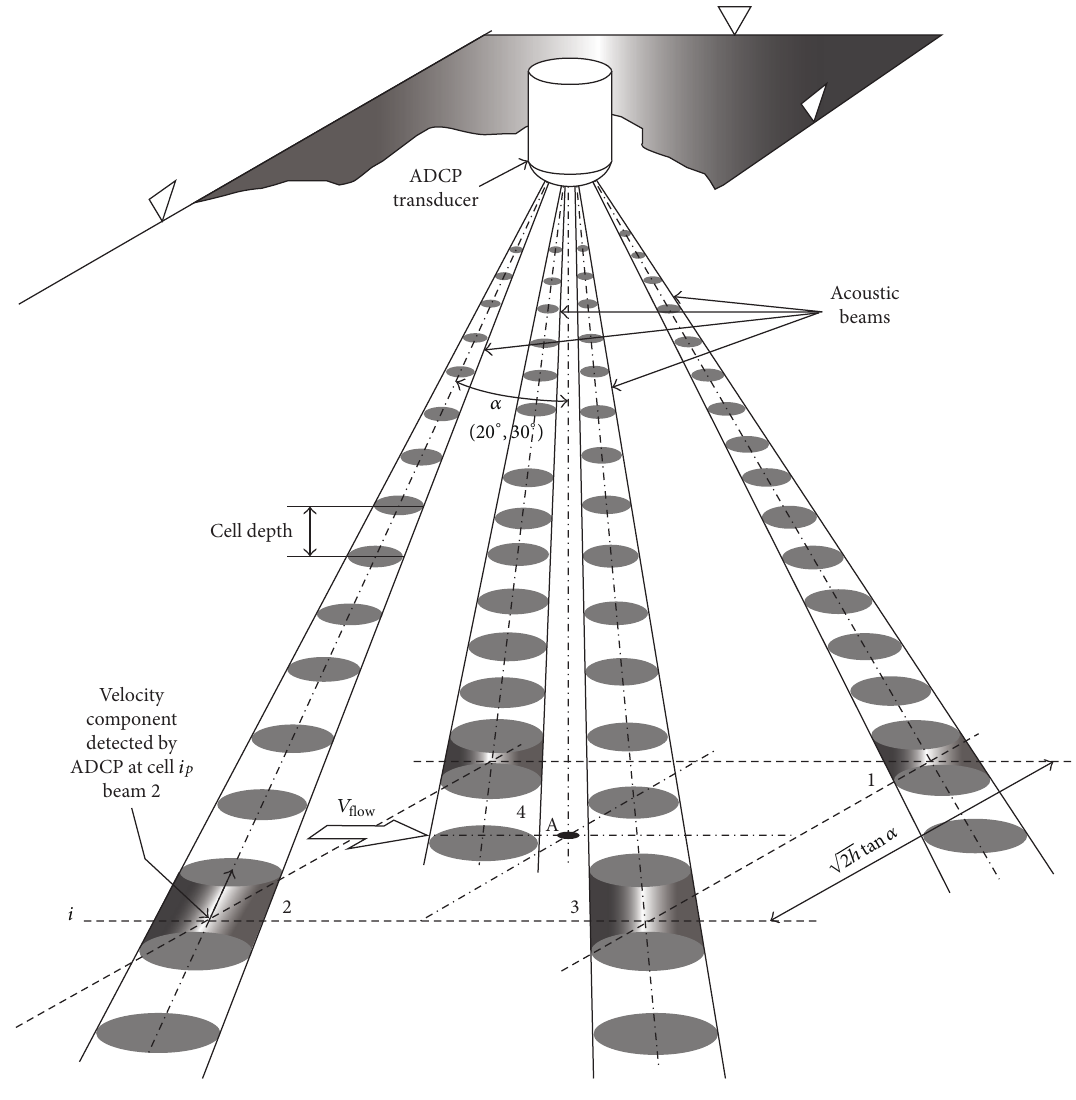
Figure 1: ADCP measurement diagram